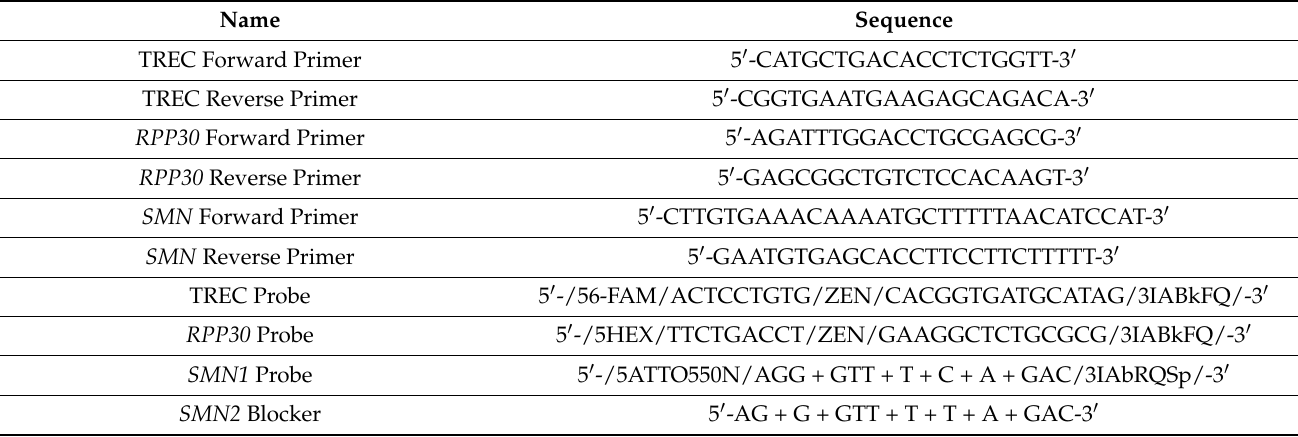
Table 2. Sequences of the primers and probes used for real-time PCR.